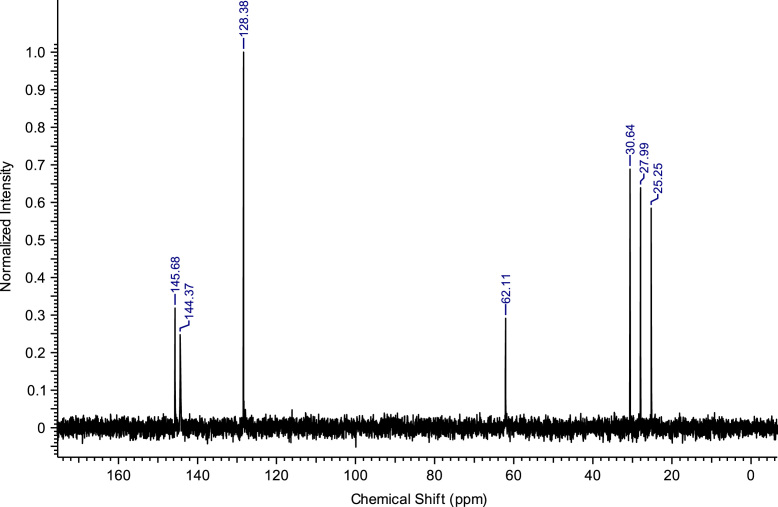
13C NMR spectra of C8(Pyr)2Br2.